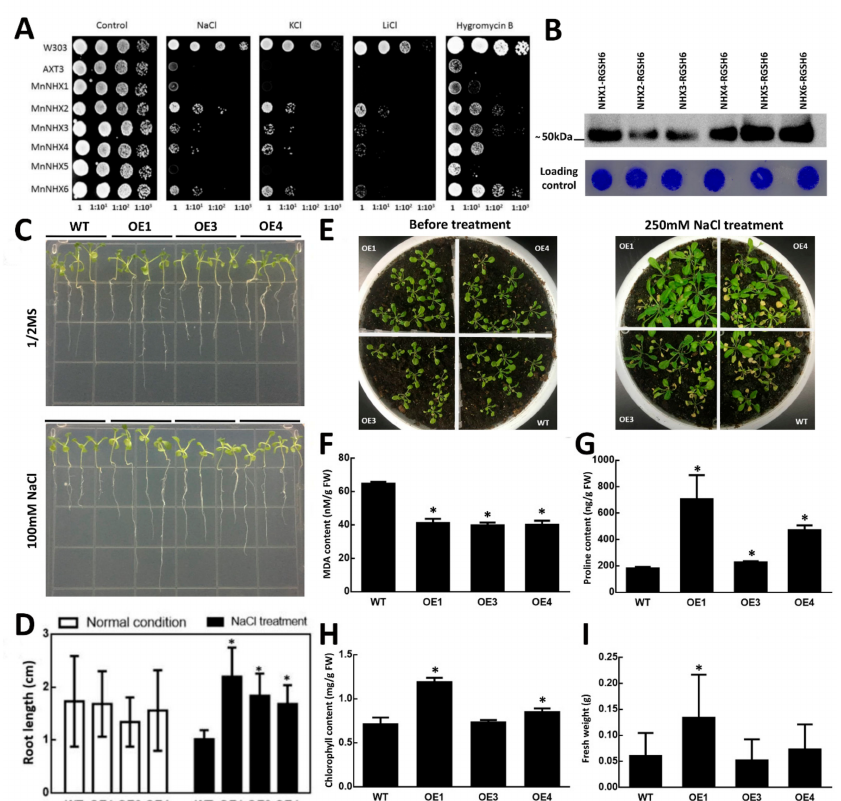
Figure 1. Salt-tolerance analyses of MnNHX6 in yeast and transgenic Arabidopsis plants. ( A ) A comparison of MnNHX family halotolerance levels in yeast. All the MnNHX family (MnNHX1–6) open-reading frames were cloned into the plasmid pYPGE15 and transformed into yeast AXT3 cells. Wild-type (WT) yeast W303 served as the positive control. In total, 4 µ L of the 10-fold serial dilutions of these strains from saturated cultures were spotted onto AP plates supplemented with NaCl (110 mM), KCl (900 mM) or LiCl (10 mM) at pH 5.8 and YPD plates supplemented with hygromycin B (25 µ g / mL). ( B ) Expression levels of the MnNHX1-6 (with RGSH6 tag) were examined. Microsomal membrane proteins (35 µ g) were separated electrophoretically and were subjected to Western blot using anti-His antibody; the loading control was done by protein staining with Coomassie Brilliant Blue. ( C ) The root growth of MnNHX6 transgenic Arabidopsis plants (The overexpression MnNHX6 transgenic lines 1, 3, and 4 were designated as OE1, OE3, and OE4, respectively) under normal and NaCl-stress conditions. ( D ) Statistical analysis of root lengths of MnNHX6 transgenic and WT (wild-type) plants. Data are means ± SDs ( n = 9), * p < 0.05. ( E ) The growth of MnNHX6 transgenic Arabidopsis and WT plants under NaCl-stress conditions. ( F – I ) The proline ( F ), malondialdehyde (MDA) ( G ), chlorophyll ( H ) contents and fresh weight ( I ) in MnNHX6 transgenic Arabidopsis and WT plants under NaCl-stress conditions. Data are means ± SDs ( n = 6), * p <